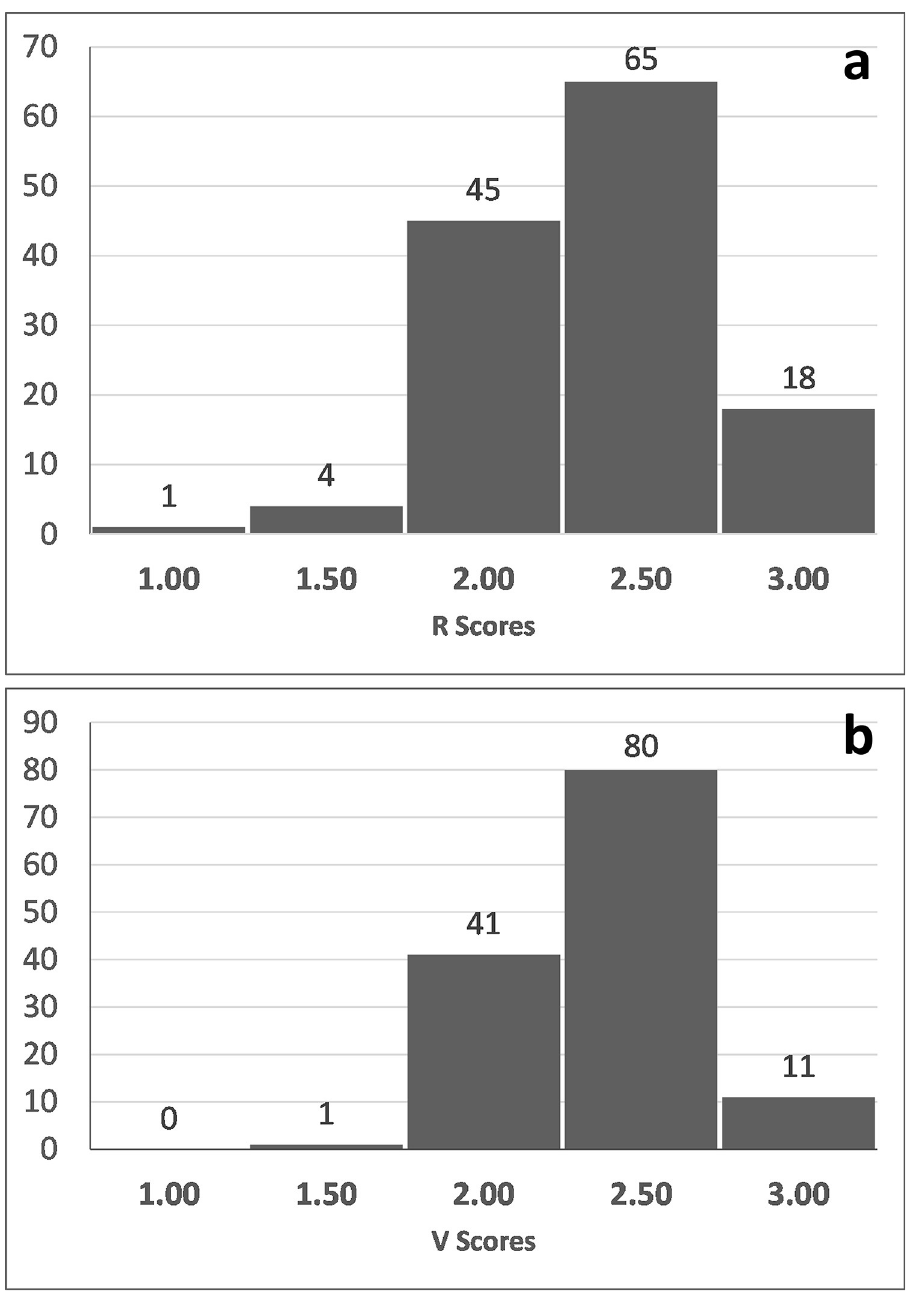
Fig 2. Frequency distribution of calculated resilience (R) scores for 133 species/stocks (a) and frequency distribution of calculated vulnerability (V) scores for 133 species/stocks (b). (97 to 102); crustaceans (103 to 122) and molluscs (123 to 133). The white sardine, Escualosa thoracata (#27; Fig 4A) had high resilience and relatively low vulnerability, while at the other end of the spectrum, the flat needlefish, Ablennes hians had a very high vulnerability and low resilience. The majority of the teleost species had medium resilience and median vulnerability (Fig 4A and 4B). All fishes in the family Ariidae (catfishes) had medium resilience and medium